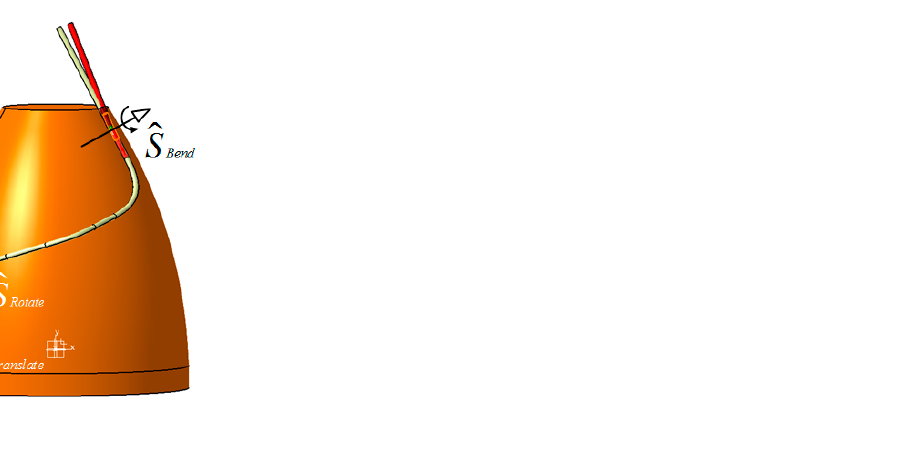
Figure 5. Dimensional variation propagation model based on the POE formula.